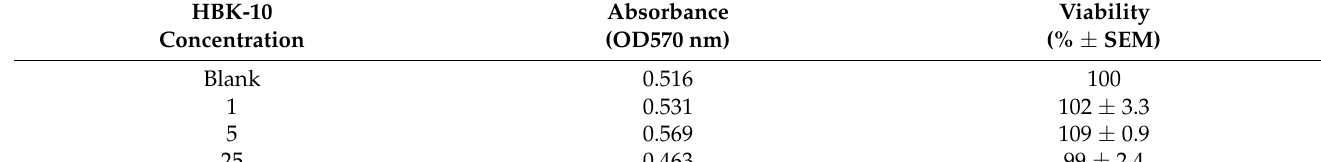
Table 1. Viability of HepG2 cells incubated with HBK-10 in concentration 1–25 µ M for 24 h.